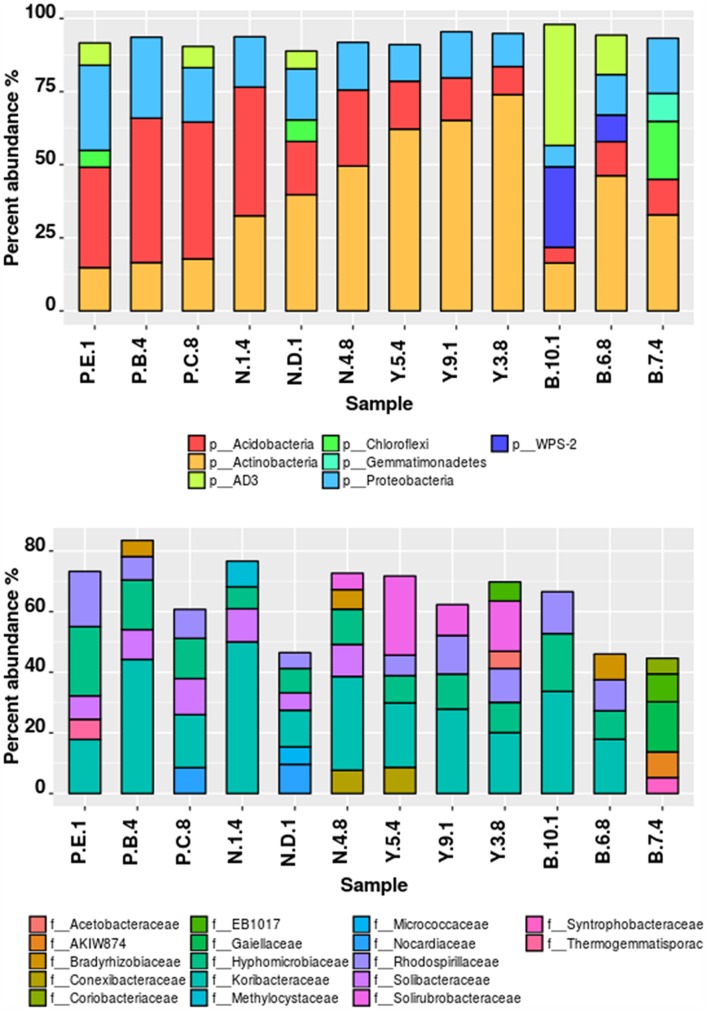
Taxonomic composition of bacterial communities associated with Rhododendron arboreum rhizosphere sites along an altitudinal gradient with increasing pH. Relative percentages of read abundance of different phylum and family level taxonomy within the different communities. (A) Sequences that could not be classified into any known phylum were removed. (B) At the family level differentiation only taxa with >1% abundance were included and not belonging to any known family were removed.